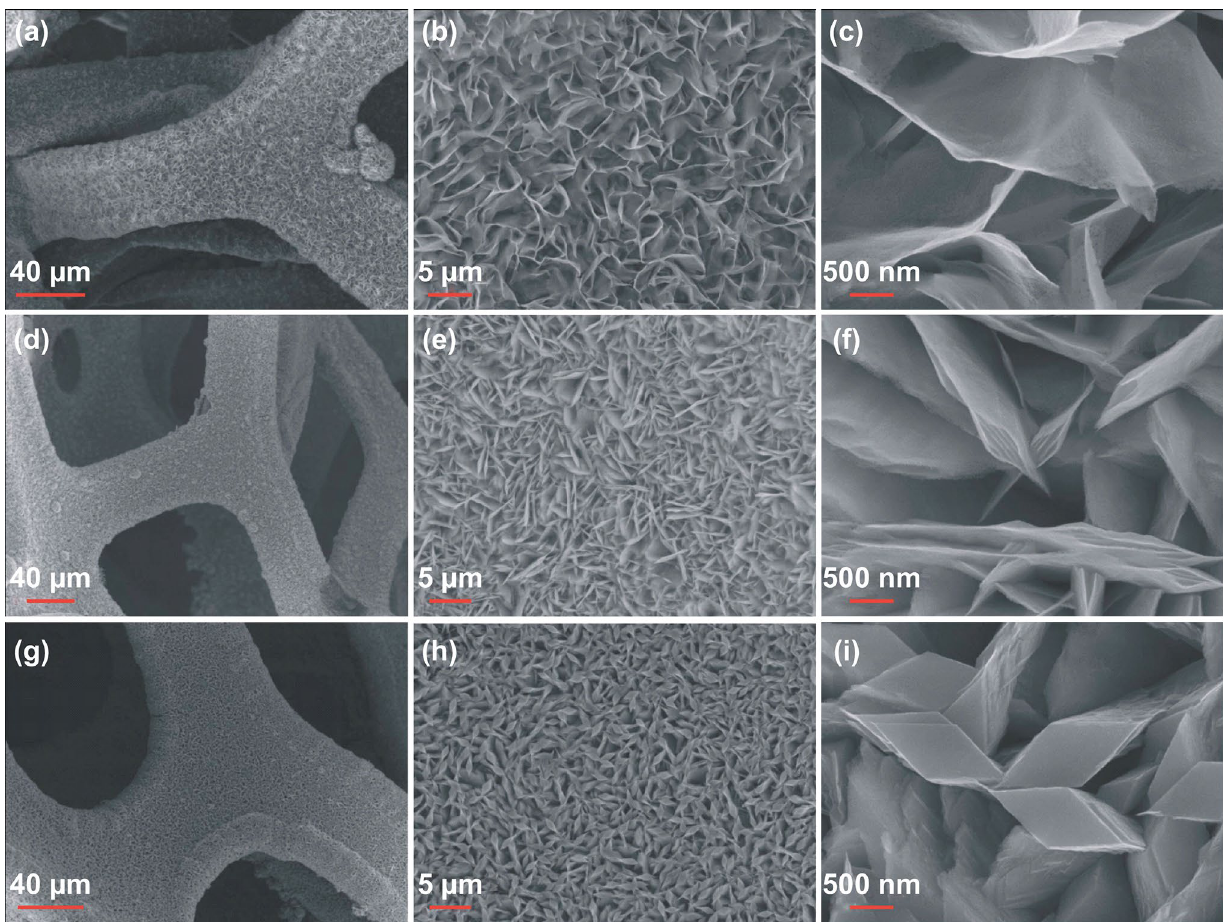
Fig. 5 FESEM images representing the effect of concentration of NH 4 F on the morphologies of NiCo 2 O 4 nanostructures: a–c 3 mmol NH 4 F; d–f 9 mmol NH 4 F; g–i 12 mmol NH 4 F. Reproduced with permission from Ref. [117]. Copyright © 2014 Elsevier